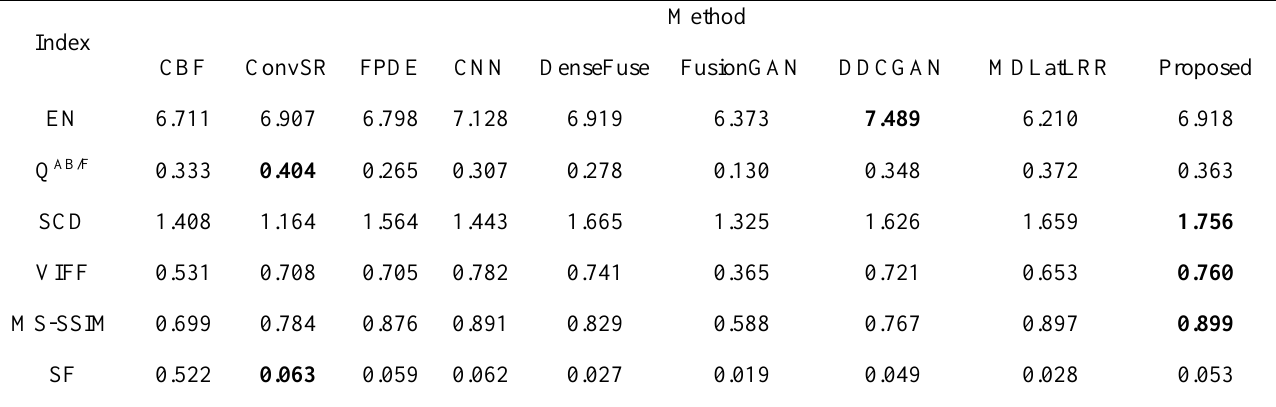
Table 2. The average quantitative value of the fusion results of 21